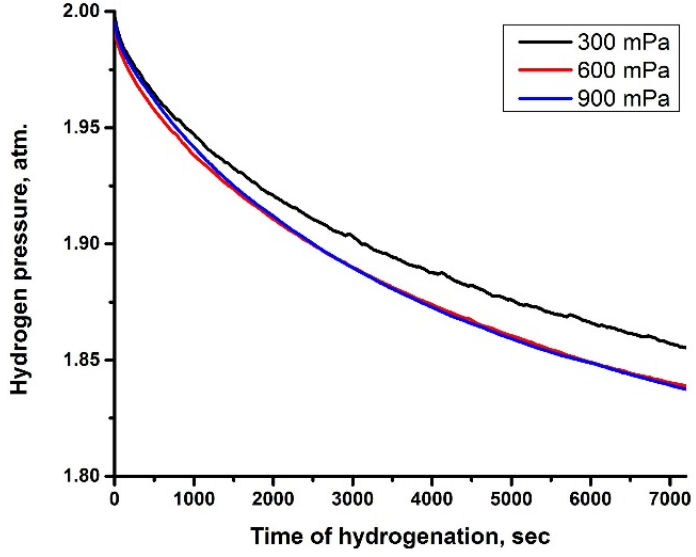
Figure 2. Hydrogen pick ‐ up curves of IN718 with Cr x N coatings for hydrogenation at 600 °C.